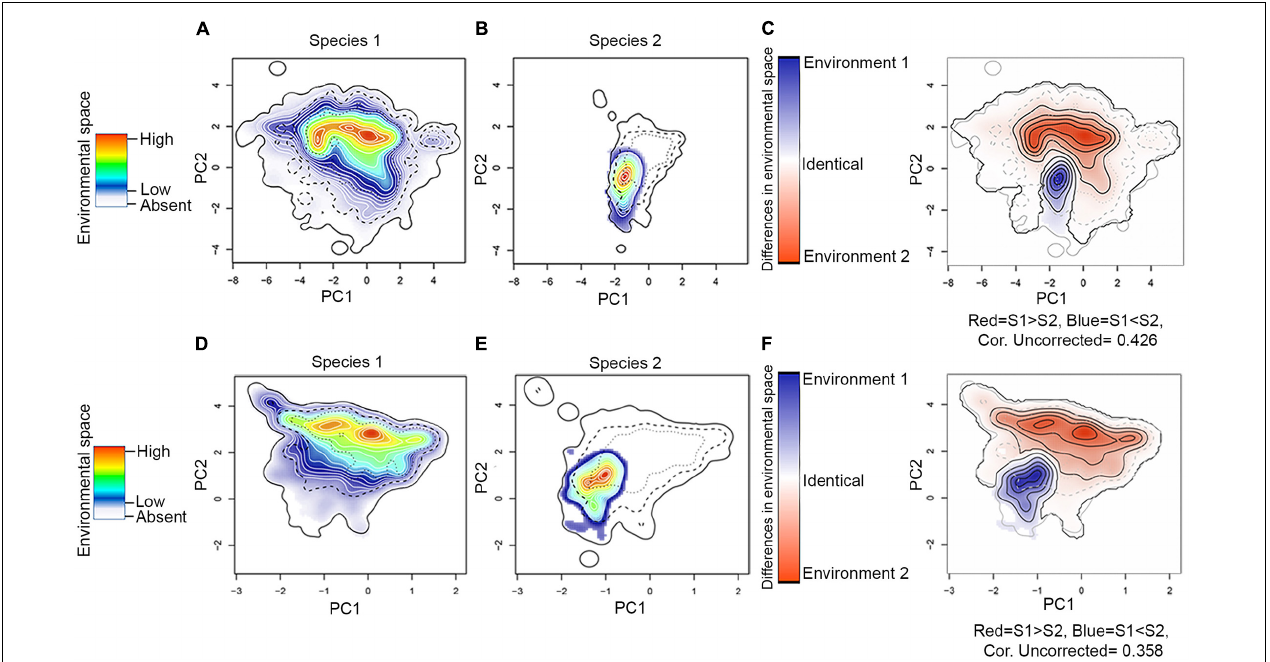
FIGURE 5 | Assessment of niche similarity. As an example, we show the Niche Overlap Test (NOT–top row) and Niche Divergence Test (NDT–bottom row) between H. erato (species 1) and H. himera (species 2), but other comparisons can be found in ZENODO (https://doi.org/10.5281/zenodo.5149294). (A,D) Environmental space of species 1; (B,E) environmental space of species 2; and (C,F) difference in the environmental space (E-space) of two species and Niche E-space Correlation Index (NECI). When NECI was higher than 0.5, we corrected species occupied niches by the frequency of E-space in accessible environments. Significance of NOT and NDT can be found in Table 1 . Equivalency statistic and niche background statistic for each NOT and NDT can be found in https://doi.org/10.5281/zenodo.5149294.